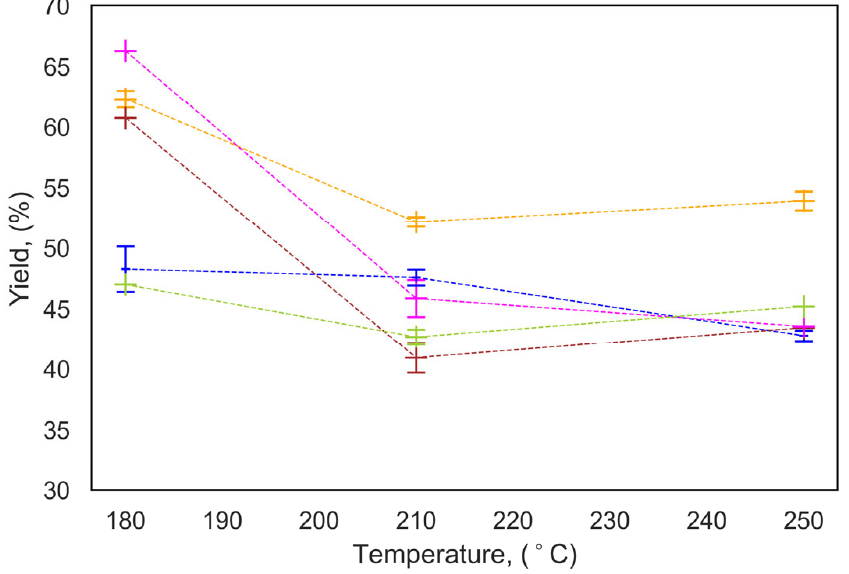
Figure 1. Effect of reaction temperature and water-to-biomass ratio on hydrochar yield, (–) washed FS-0; (–) UFS-0; (–) FS-3; (–) UFS-3; (–) Dry S, W:B = 3. Dashed lines are added to guide the eye.